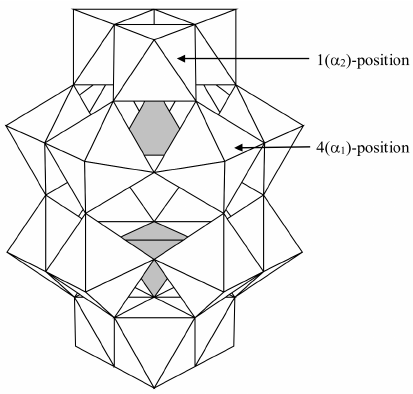
Figure 1. Structure of the Well–Dawson-type